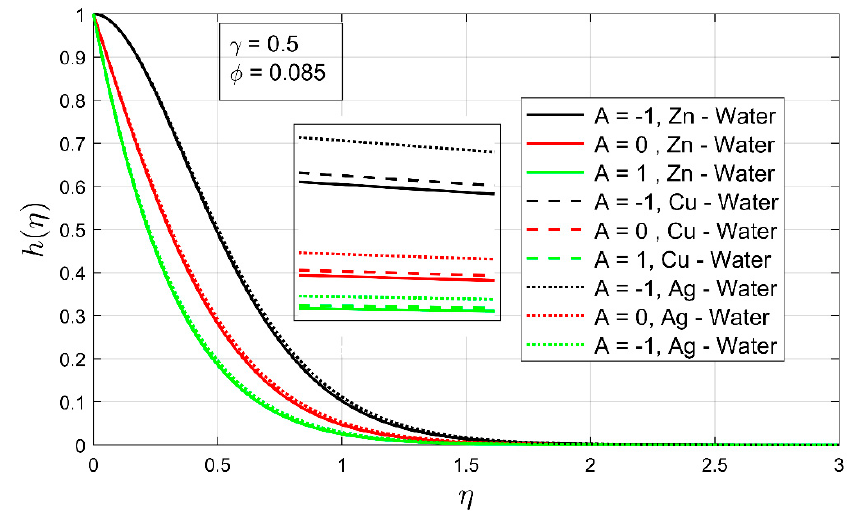
Figure 9. The temperature profile h ( η ) as a function of temperature exponent A .